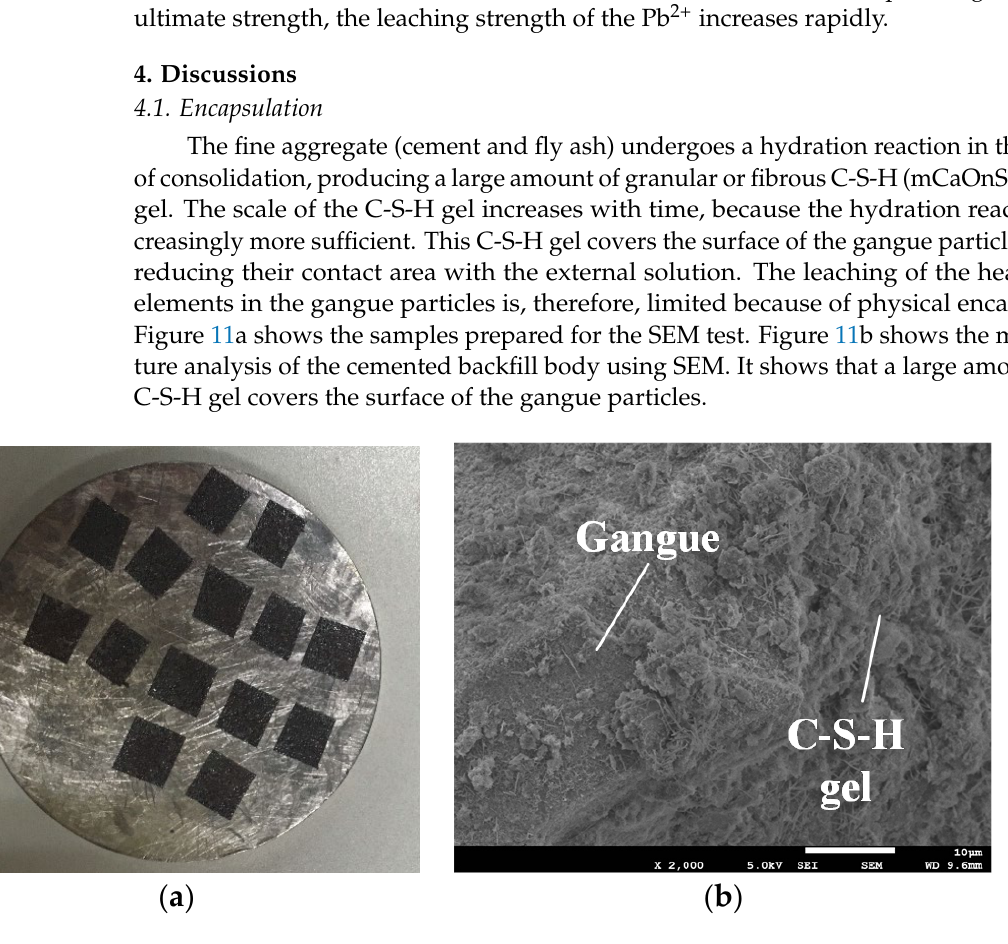
Table 3. The information of the X-ray and the test setup.